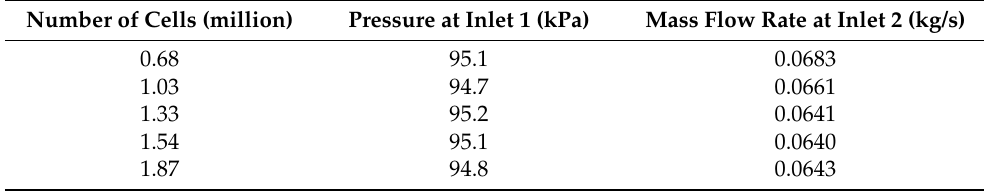
Table 3. Results of the grid sensitivity analysis for the swirling drill bit. Number of Cells